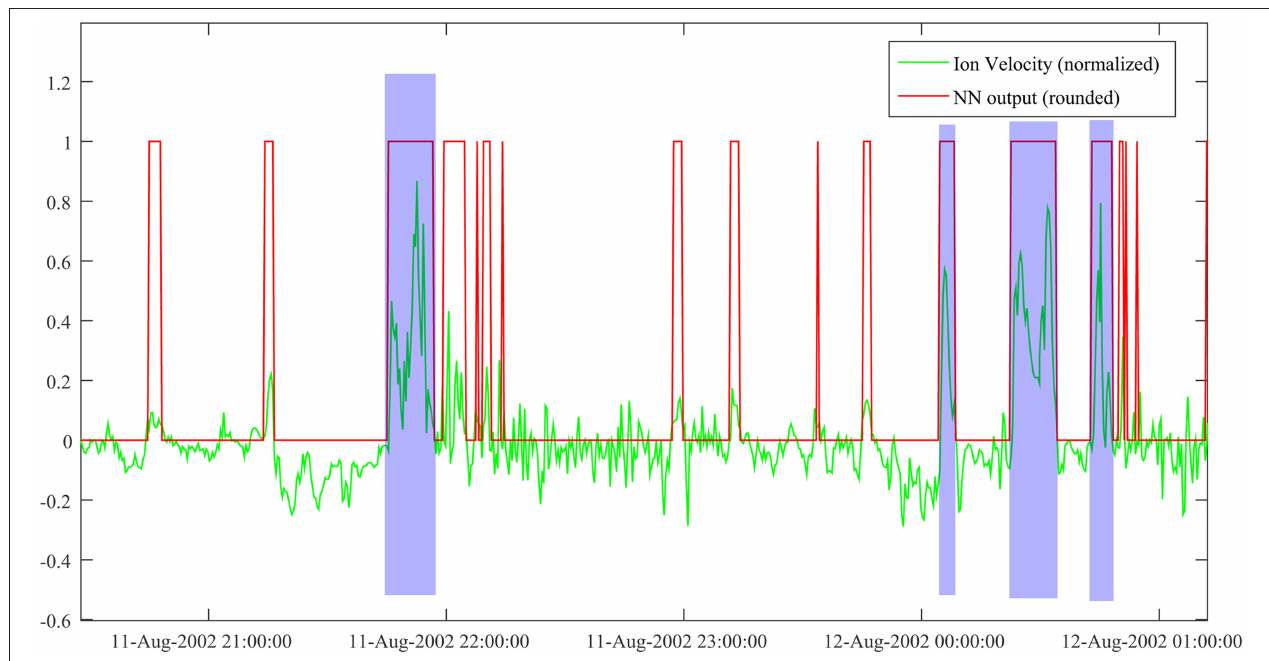
FIGURE 5 | NN output for ion velocity data. Velocity is normalized to a maximum value of 1,000 km/s. Actual BBF events are shaded in blue.